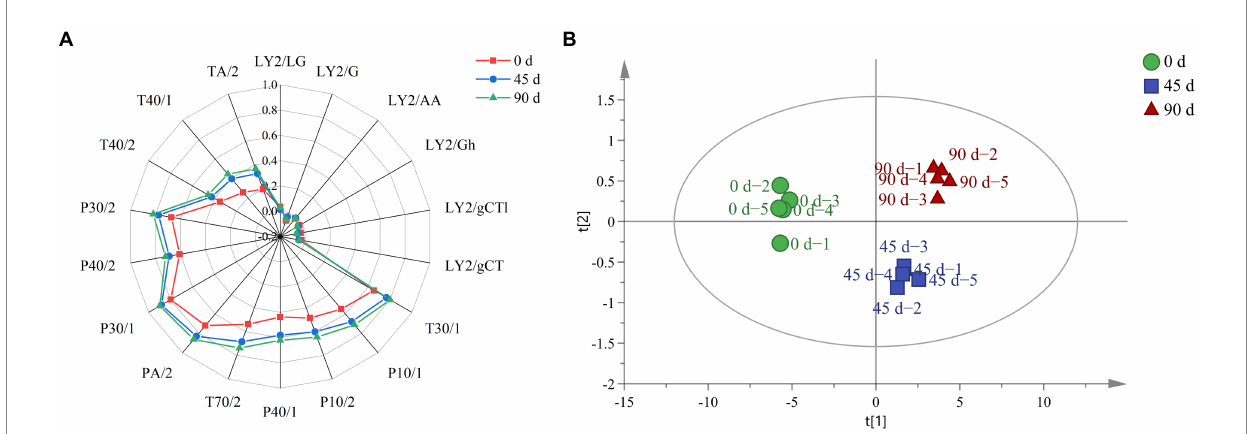
FIGURE 7 E-nose for LSCKs fermented for 0, 45, and 90 days. (A) Radar graph of the LSCK. Red, blue, and green indicates 0, 45, and 90 days fermented LSCKs, respectively. (B) PCA plot of the 0, 45, and 90 days fermented